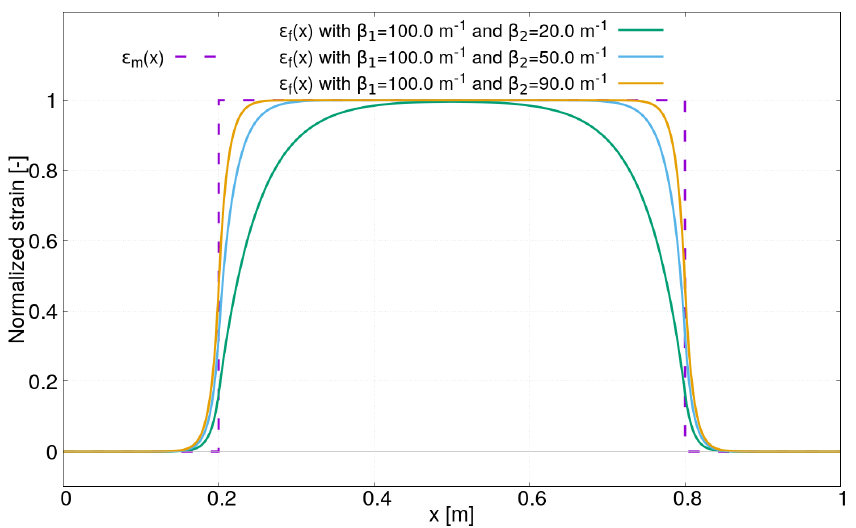
Figure 4. Strain profiles (cid:101) f ( x ) under a uniform field for different strain lag parameters β 2 = 20,50,90 m − 1 and β 1 = 100 m − 1 .